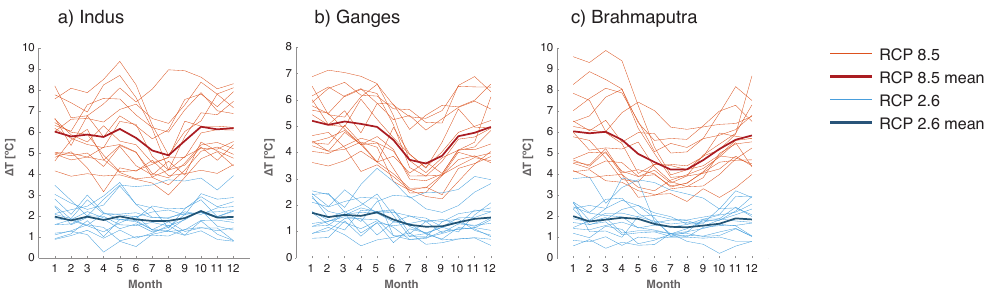
Figure 8. Projected future temperature change from 1971–2000 to 2071–2100 in the (a) Indus, (b) Ganges and (c) Brahmaputra basins. Thin lines show the individual CMIP5 models, while stronger lines show the multi-model mean.